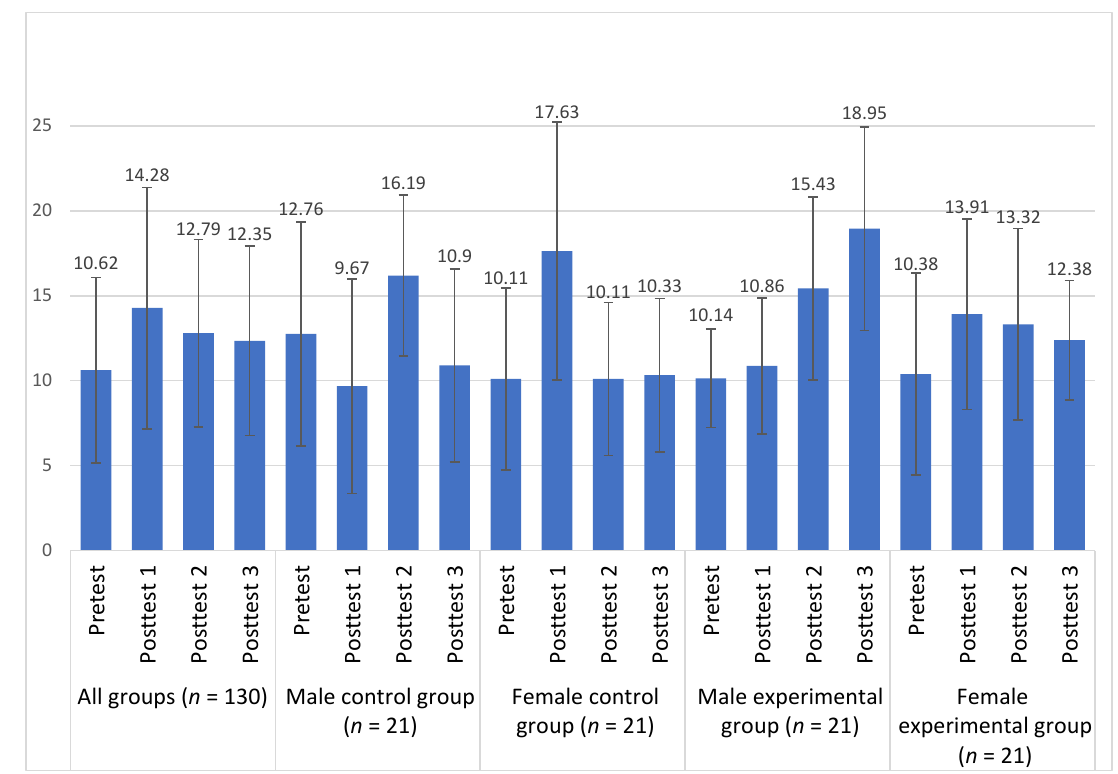
Figure 5. Mean Differences Between all Tests Within all Groups.